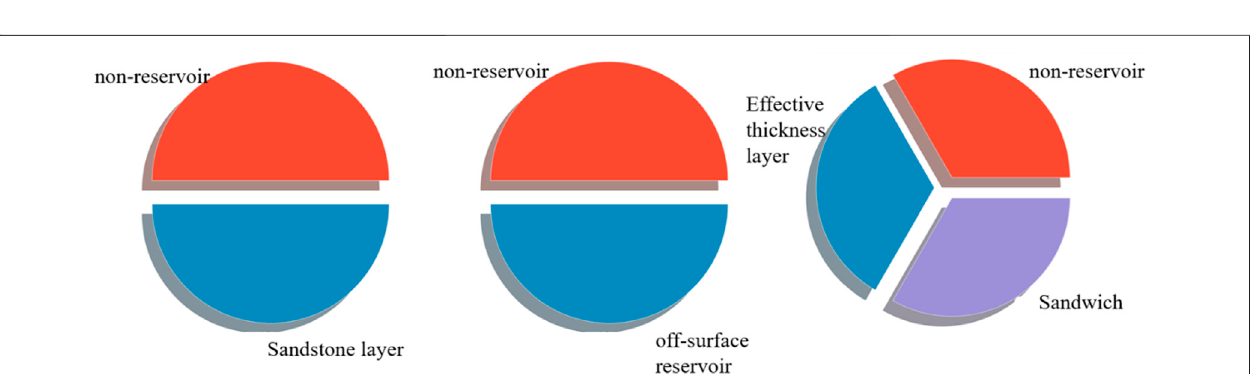
FIGURE 4 | Distribution ratio of the sandstone and reservoir after SMOTETomek sampling.